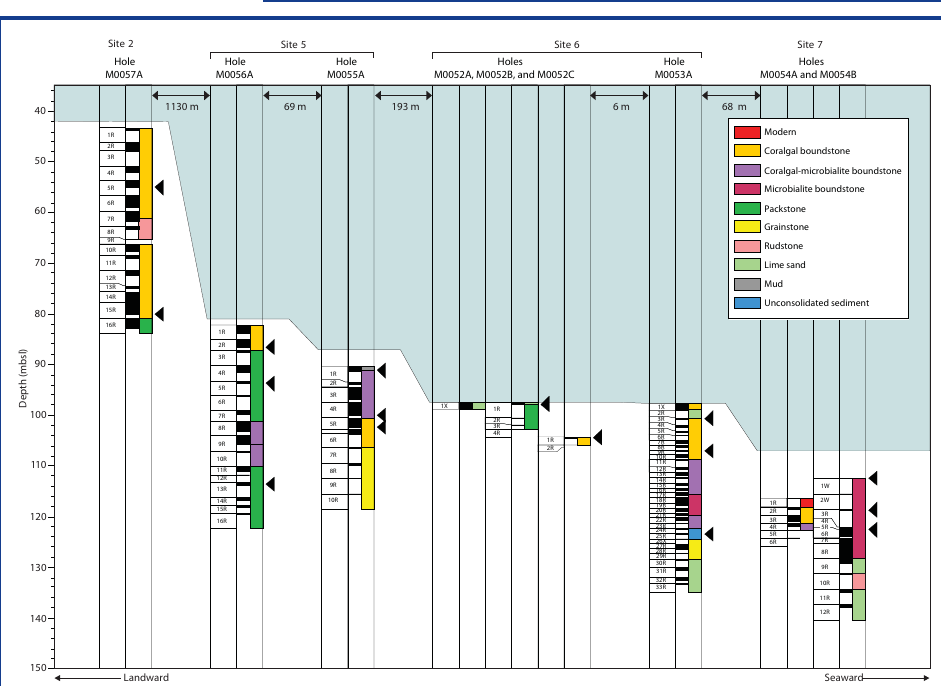
Figure 6. Lithostratigraphic summary of holes on the Transect RIB-02 (Sites from landward to seaward; M0051A, M0049A, M0049B, and M0050A).